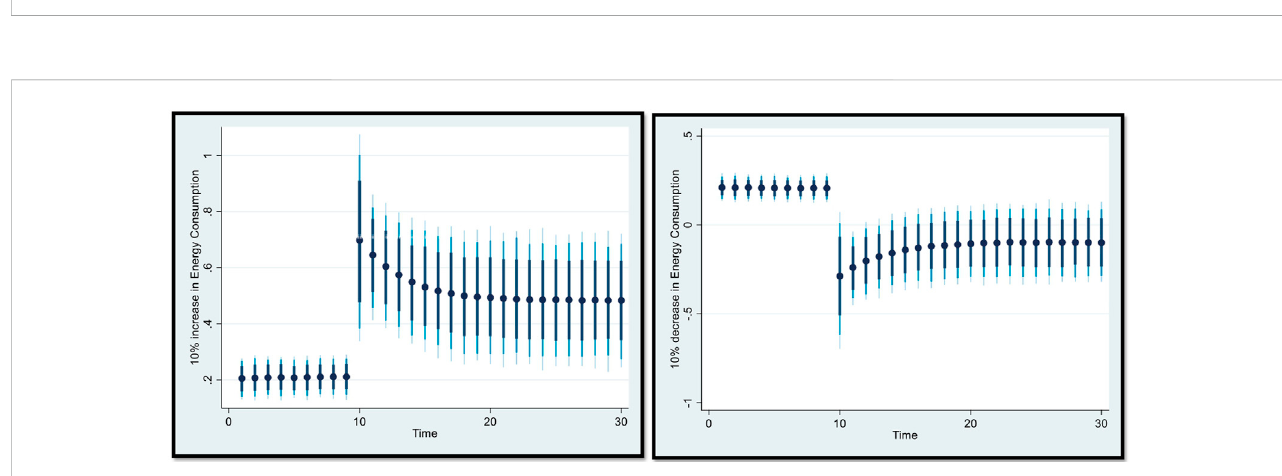
FIGURE 4 Impulse response plot for energy consumption and CO 2 emissions. An increase and a decrease of 10% in energy consumption and its effect on CO 2 emissions, where dots denote the average prediction value. The dark blue to light blue lines show 75%, 90%, and 95% con fi dence intervals, respectively.